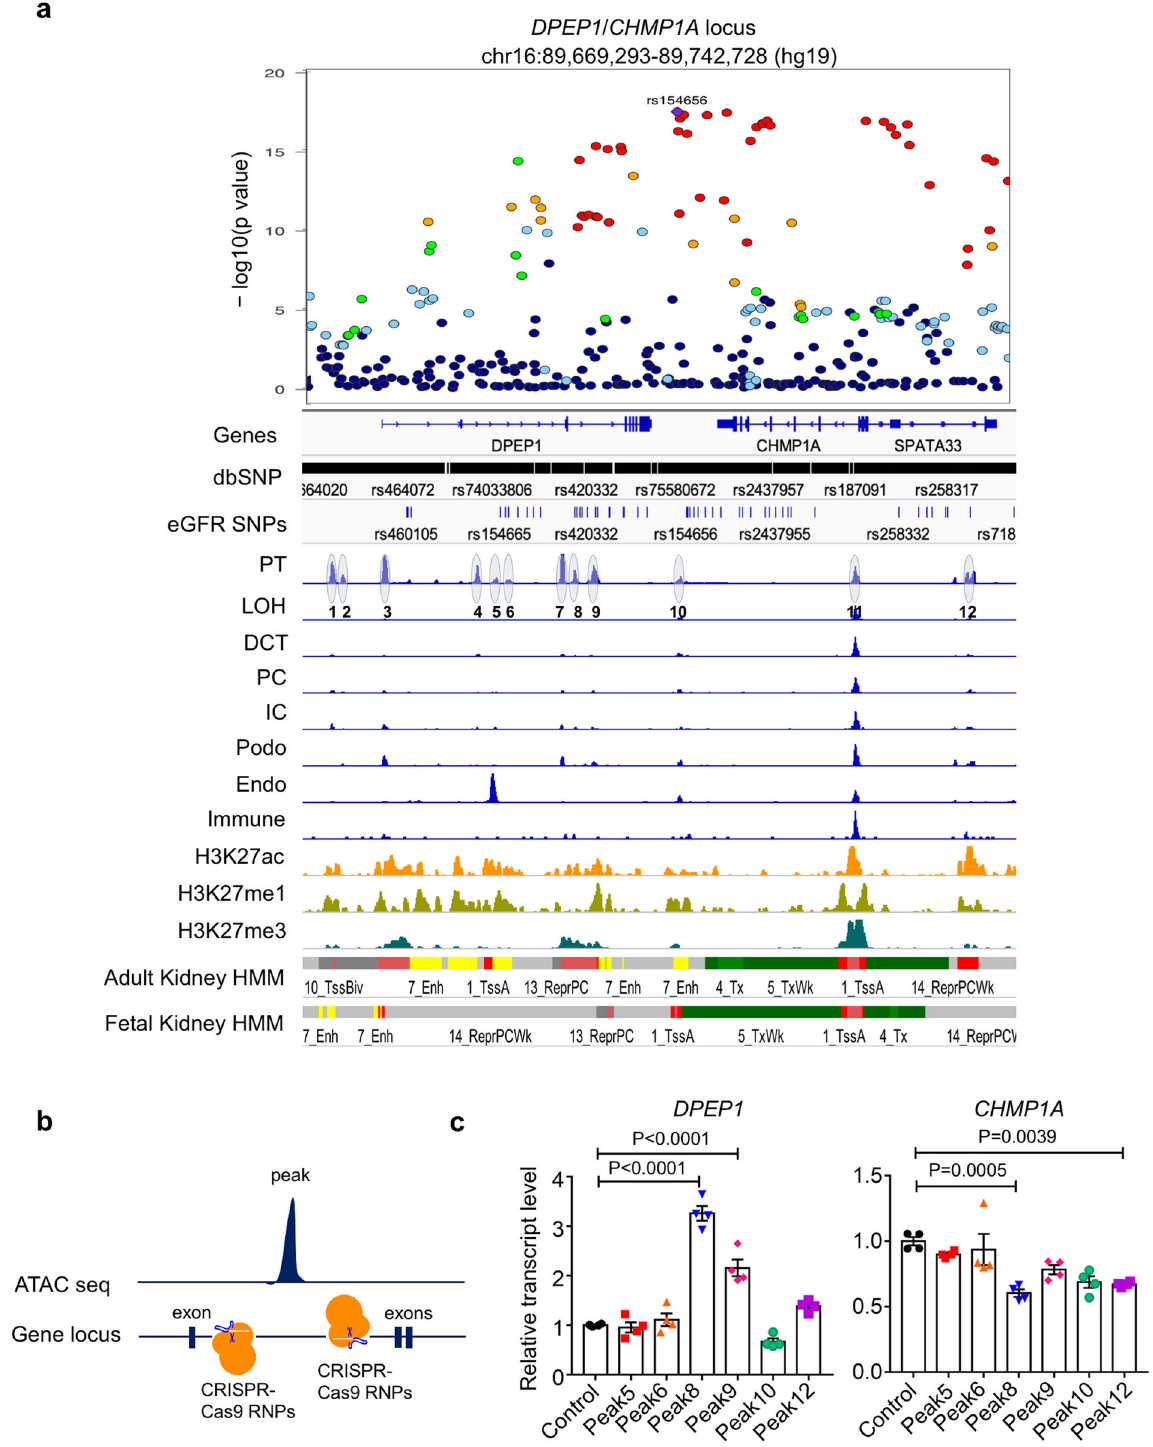
Fig. 2 Fine mapping of the GWAS locus via human kidney single nuclei ATAC-seq analysis coupled with genome editing. a From top to bottom: locuszoom plots of eGFR GWAS; Gene browser view of the single nucleotide polymorphisms within the regions; genome browser view of chromatin accessibility for proximal tubules (PT), loop of Henle (LOH), distal convoluted tubule (DCT), collecting duct principal cell types (PC), collecting duct intercalated cells (IC), podocytes (Podo), endothelial cells (Endo), immune cells (Immune); genome browser view of whole kidney H3K27ac, H3K4me1, and H3K4me3 histone ChIP-seq; ChomHMM annotation human adult and fetal kidneys. Proximal tubule-speci fi c open chromatin region across this region was circled and numbered. b Schematic of CRISPR/Cas9 mediated open chromatin region deletion. c Relative transcript levels of DPEP1 and CHMP1A following open chromatin region deletion ( n = 4). All data are represented as mean ± SEM. P value was calculated by one-way ANOVA with post hoc Tukey test. P < 0.05 is statistically signi fi cant. A Source Data fi le is available for this fi